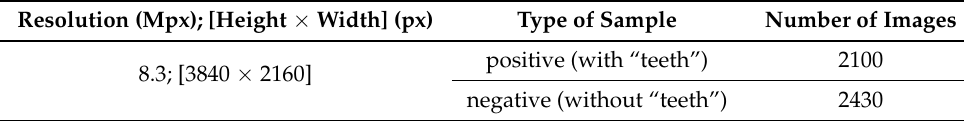
Table 1. Specifications of the training dataset for the detection of tiles “teeth”.